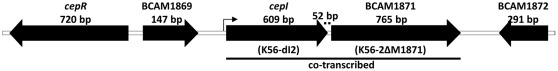
Genetic organization of the BCAM1871 locus.BCAM1871 is located downstream from cepI with 52 bp separating cepI and BCAM1871 which were determined to be co-transcribed (solid line) using RT-PCR. Size (bp) of each ORF is indicated. The cepI transcription start site is located 28 bp upstream of the ATG start codon [18]. One promoter (arrow) was identified for the cepI-BCAM1871 operon, and this was located upstream of cepI and included in the cepI promoter::lux fusion (pCP300). Nomenclature used to describe K56-dI2 and K56-2ΔBCAM1871 mutants.